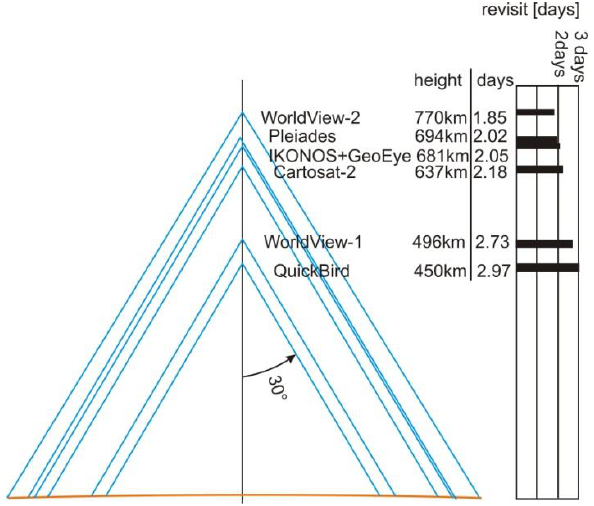
Figure 4. Flying elevation, field of regard for 30° nadir angle and revisit time for 53° latitude The revisit time for the equator R equator can be estimated depending upon the flying elevation with the approximation in formula 1.